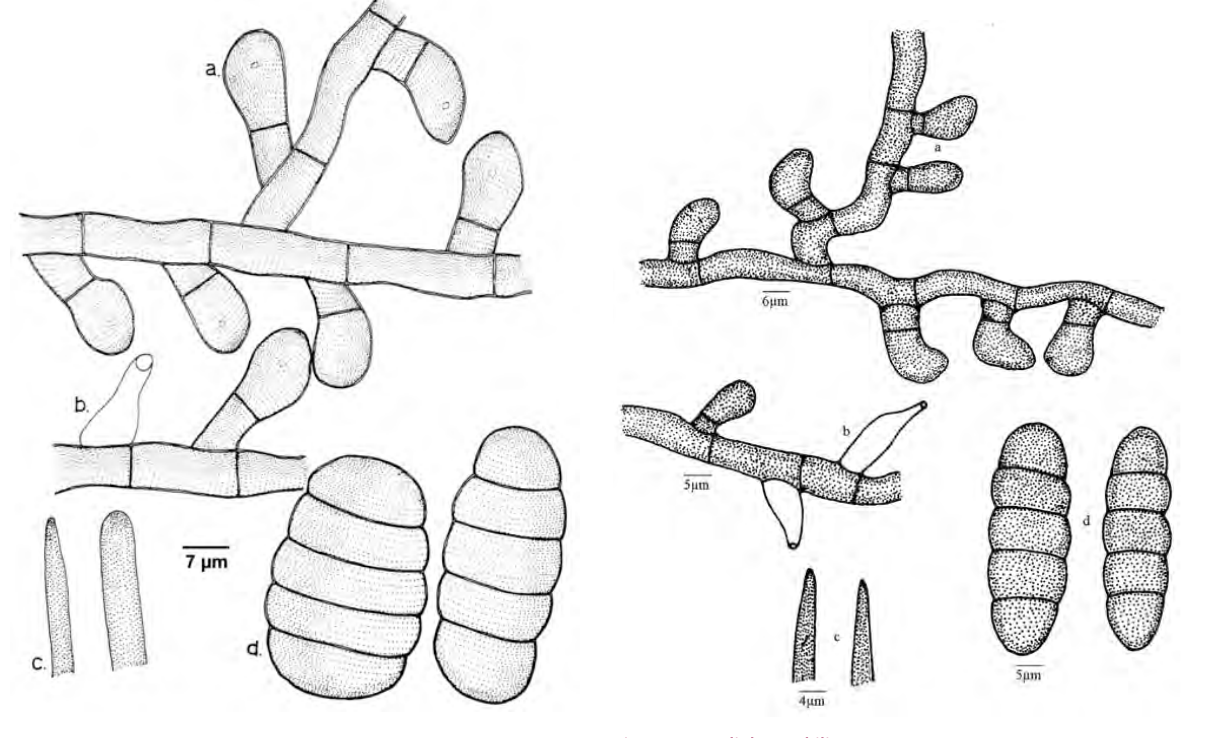
Figure 91. Meliola litseae var. rotundipoda a - Appressorium; b - Phialide; c - Apical portion of mycelial setae; d -